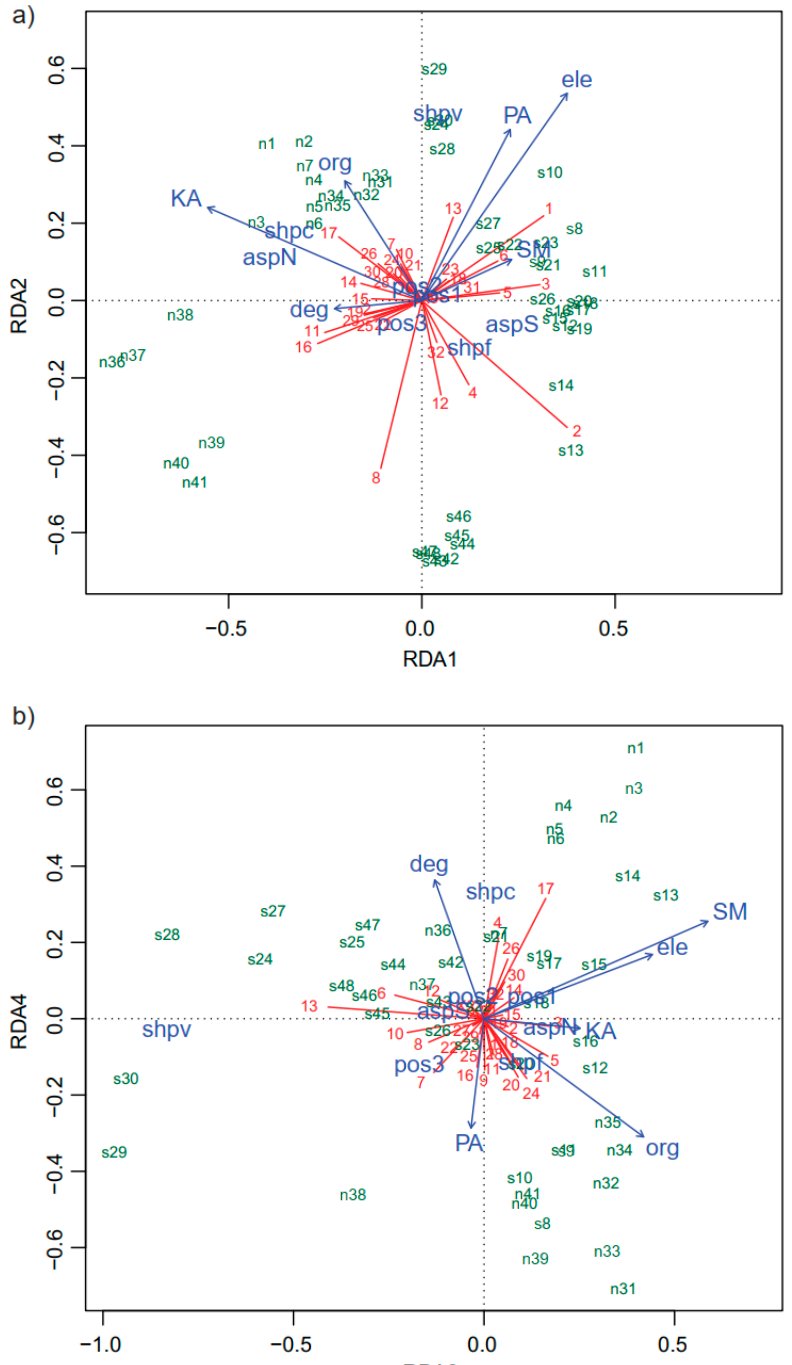
Figure 3. Redundancy analysis (RDA) of community composition on environmental variables on the first four canonical axes: ( a ) axis1 and 2, ( b ) axis 3 and 4. (ORG, organic matter; SM, soil moisture; PA, available phosphorous; KA, available potassium; ele, elevation; aspN/S, north/south aspect; shpc/f/v, shape concave/flat/convex; deg, slope degree; pos1/2/3, position up/middle/down. Site code ni and si indicate plot is on north and south aspect respectively. Species code: 1, Onosma sinicum Diels ; 2, Caryopteris terniflora Maxim. ; 3, Sophora davidii (Franch.) Skeels ; 4, Bauhinia brachycarpa var. microphylla (Oliv. ex Craib) K. et S. S. Larsen ; 5, Indigofera bungeana Walp. ; 6, Caryopteris bicolor (Roxb. ex Hardw.)